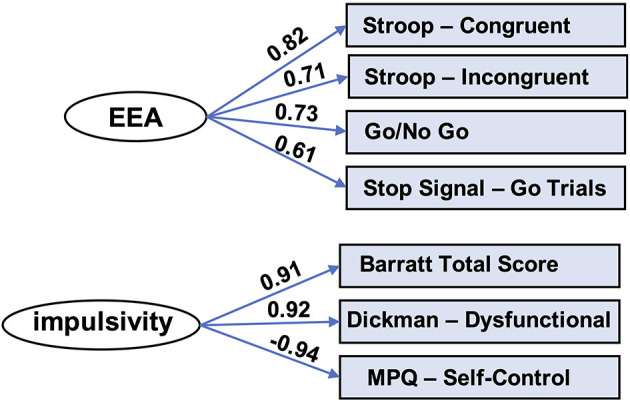
Factor models for EEA and impulsivity. Factor analysis yielded latent variables for efficiency of evidence accumulation (EEA) and impulsivity. MPQ, Multidimensional Personality Questionnaire.